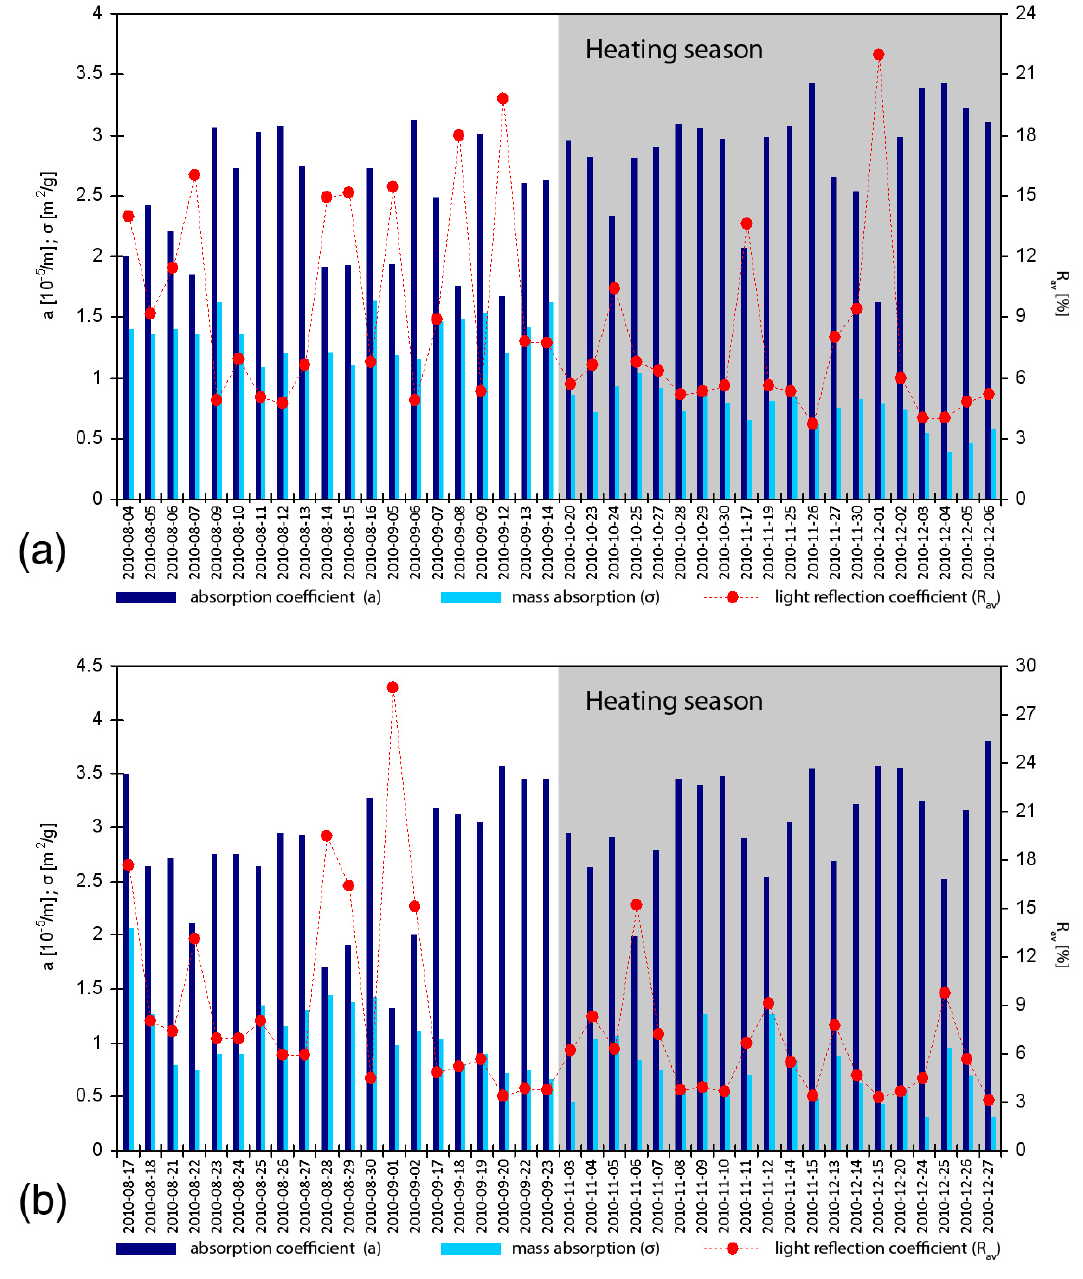
Figure 6. Optical parameters of PM 1 ( a ) and PM 2.5 ( b ) at UT (urban traffic site). The mass absorption coefficient ( σ ) at RB was higher for PM 1 in the heating season than in the non-heating one, which could have been related to the higher content of the secondary inorganic (sulphates) and organic aerosols in PM 1 in the non-heating season [14,33]. It seems that the phenomenon could explain the occurrence of the visibly higher values of the mass absorption coefficient ( σ ) for PM 1 than for PM 2.5 . Perhaps, the EC-rich PM 1-2.5 particles might be even richer with the light-dispersing sulphates or secondary organic compounds [12,33]. As a result, their ability to absorb light was much lower than the light absorption ability demonstrated by the submicron particles. Consequently, the PM 2.5 fraction containing PM 1–2.5 and PM 1 had lower ability to absorb light (calculated per PM mass) than PM 1